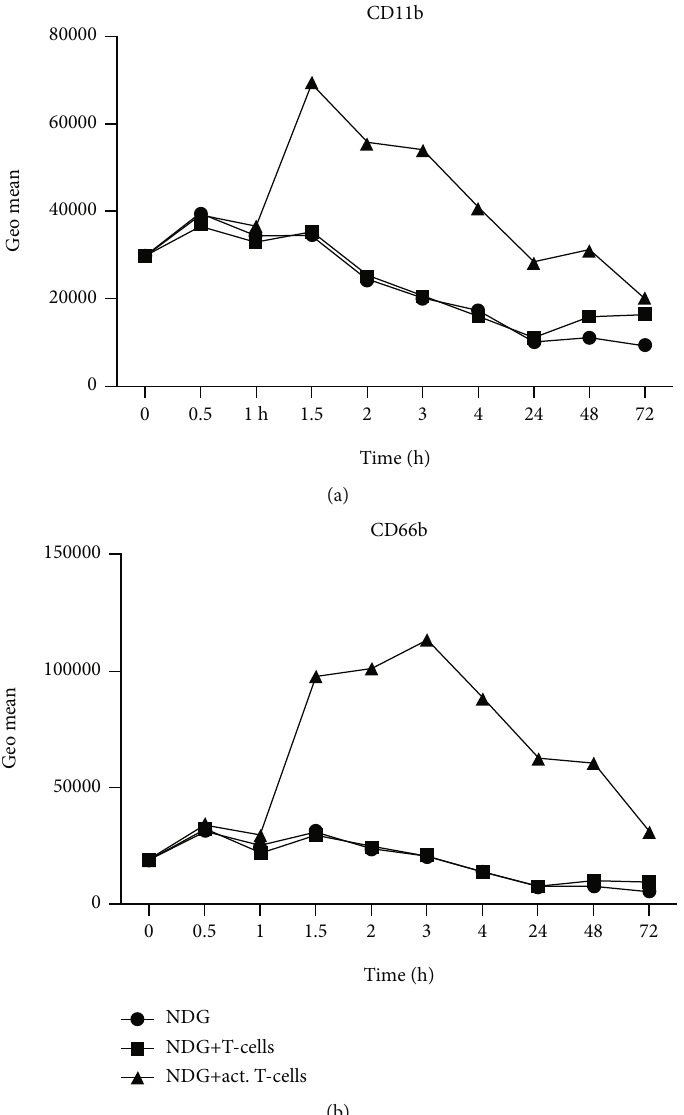
Figure 3: Neutrophil activation markers CD11b and CD66b increase during coculture with CD3/CD28 activated T-cells. (a) CD11b expression over time (72 h) on NDG alone in culture (ring), on NDG in coculture with CD3/CD28 activated T-cells (square), and on NDG in coculture with nonactivated T-cells (rectangle). (b) CD66b expression over time. These are representative plots from two